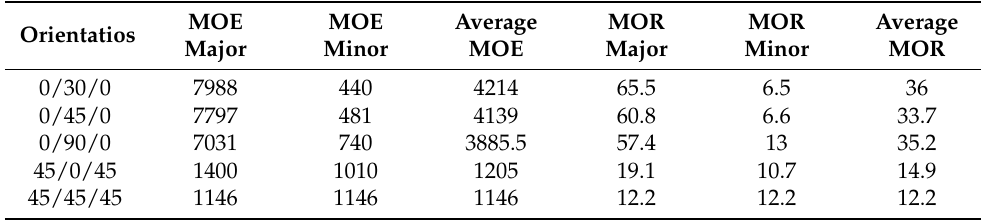
Table 4. The average values of MOE and MOR of